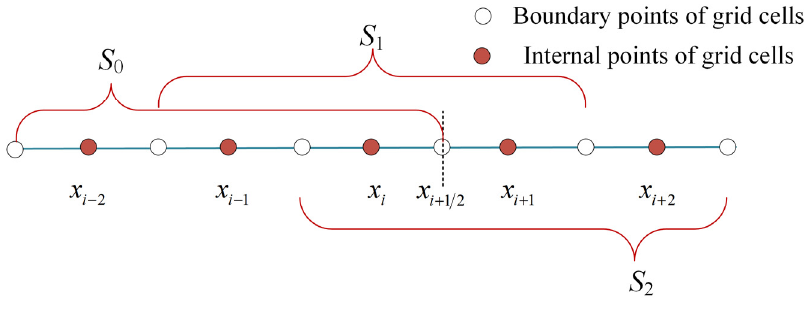
Figure 2. Computational stencils of